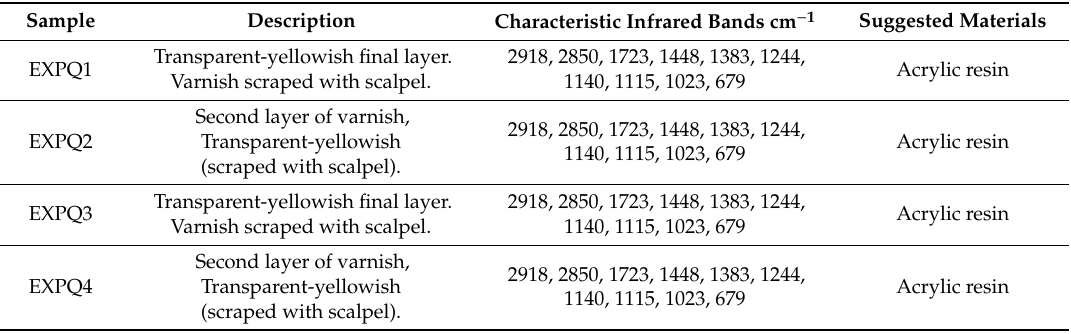
Table 2. Results of IR.